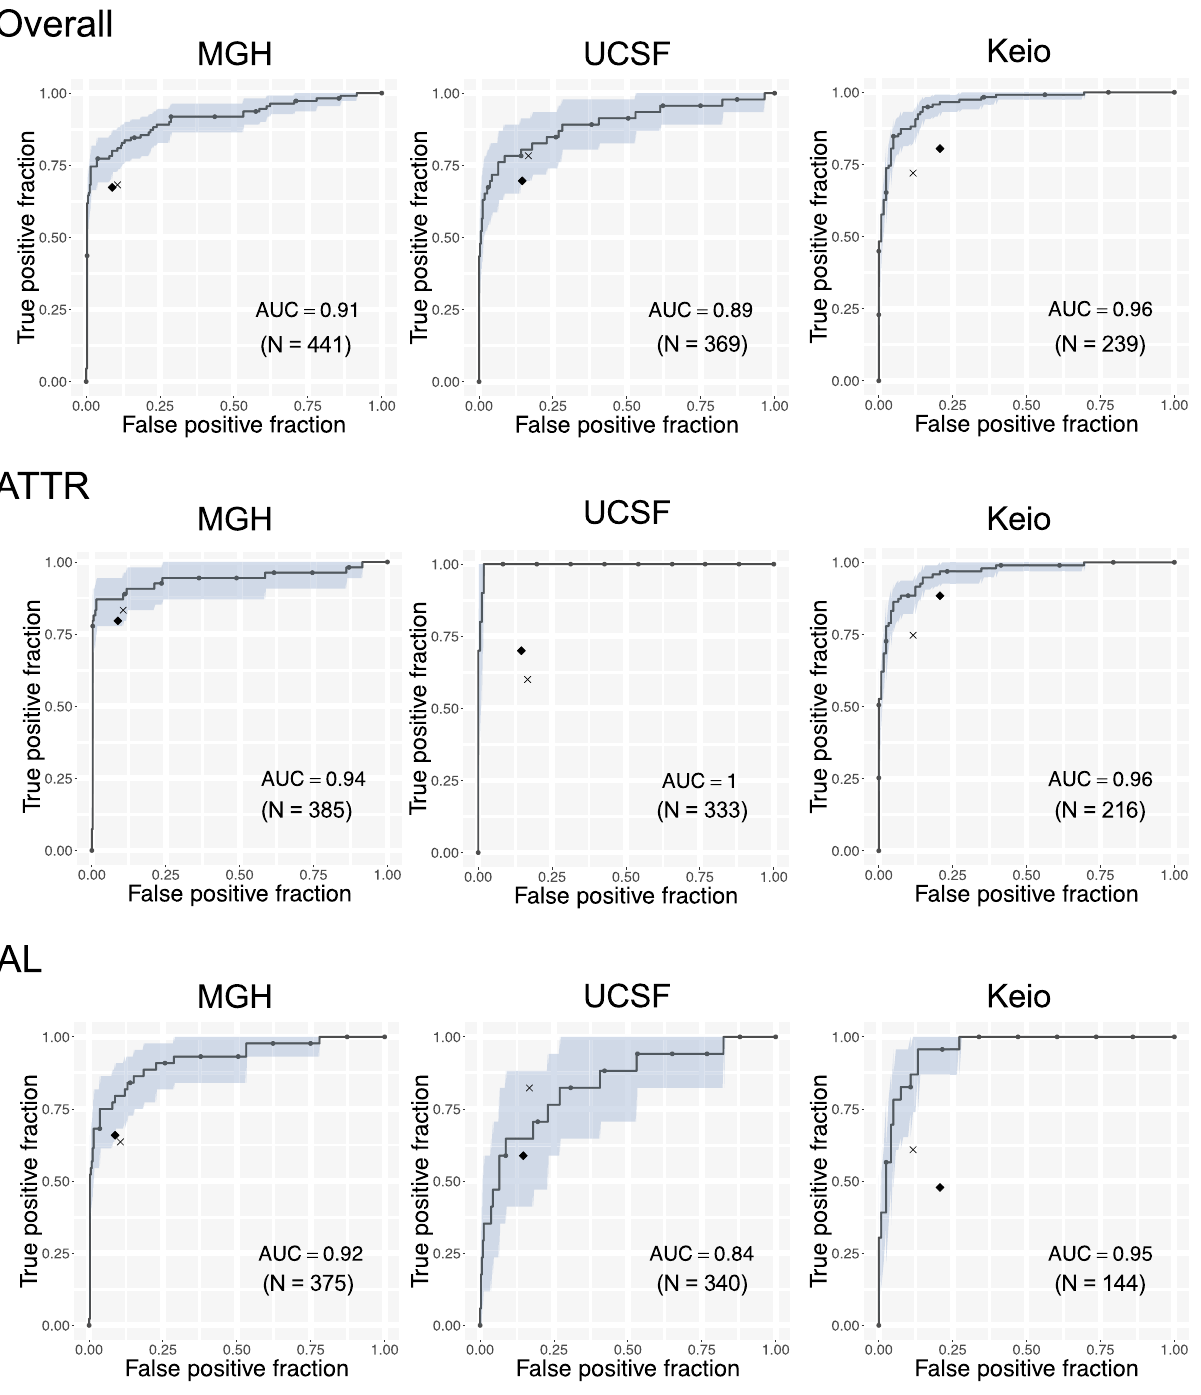
Fig. 4 Comparison of the echocardiography model with expert interpretation. ROC plots for detecting cardiac amyloidosis for each institution and amyloid type. The area in light blue represents the 95% CI for the true positive fraction for a given false positive fraction calculated by bootstrap. The black diamond represents the performance of the general cardiologist interpretation and the x represents the performance of the echocardiography expert cardiologist for detecting cardiac amyloidosis. N is the numbers of studies. Source data are provided as a Source Data fi le. ATTR: amyloid transthyretin, AL: amyloid light-chain, MGH: Massachusetts General Hospital, UCSF: University of California San Francisco, Keio: Keio University. AUC: area under the